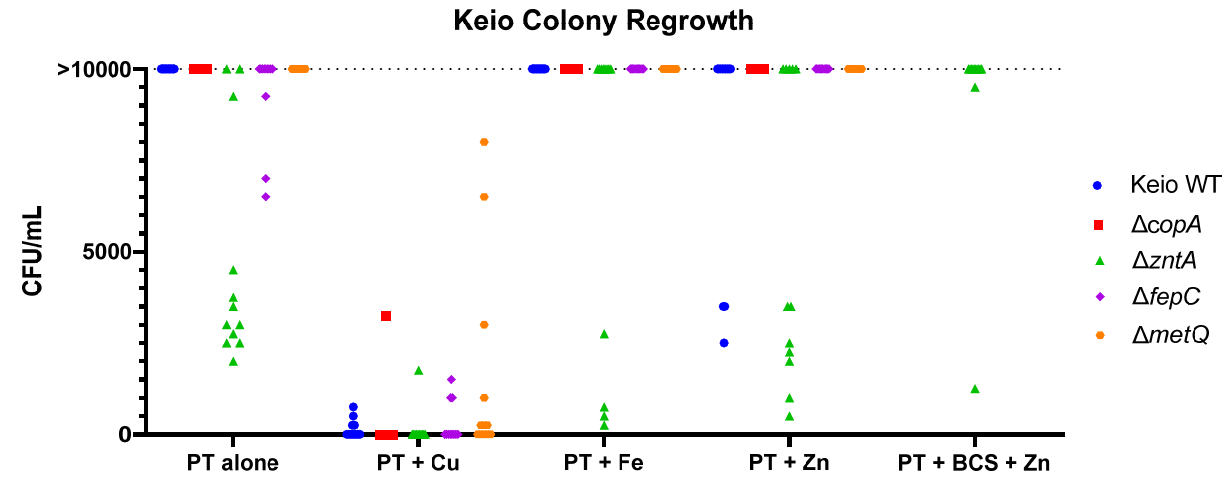
Figure 7. Ability of PT to kill E. coli K-12 BW25113 (Keio WT) and the knockout strains, ∆ copA , ∆ zntA , ∆ fepC , and ∆ metQ . Bacteria treated for 20 h with the minimum inhibitory concentration of pyrithione for that condition (Table 3) with or without 10 µ M Cu, Fe, Zn, or 1.92 mM BCS, were plated on fresh LB agar and incubated at 37 ◦ C for 24 h prior to colony enumeration. Each point on the graph represents an individual replicate. Number of viable cells (measured as CFU/mL) at 0 h for the untreated bacteria samples were as follows: Keio WT = 1.7 × 10 6 , ∆ copA = 1.3 × 10 6 , ∆ zntA = 1.4 × 10 6 , ∆ fepC = 0.7 × 10 6 , and ∆ metQ = 2.0 × 10 6 .